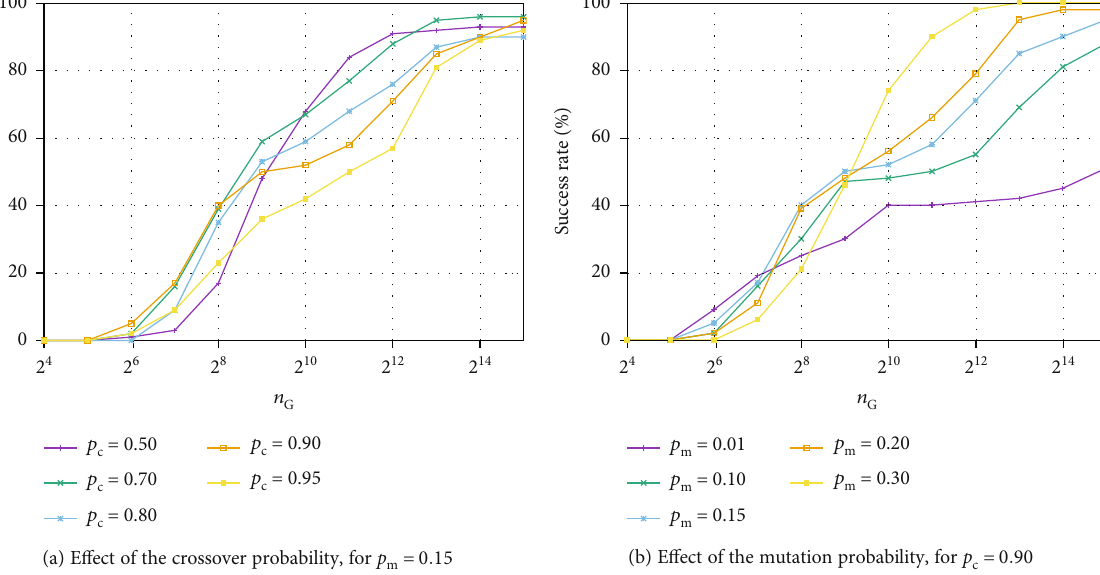
or mutation p probabilities. The c m